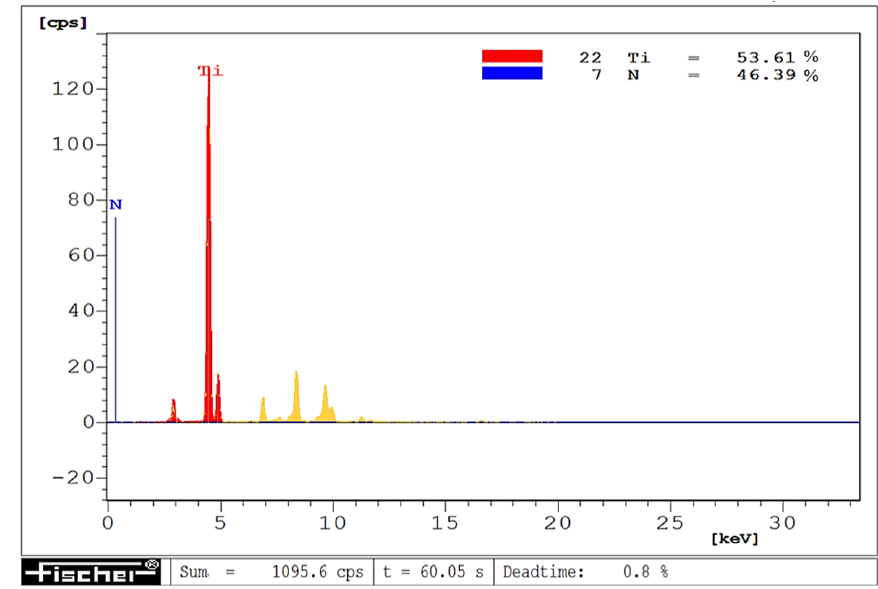
Figure 16. EDXRF image of a TiN coating before laser heating.